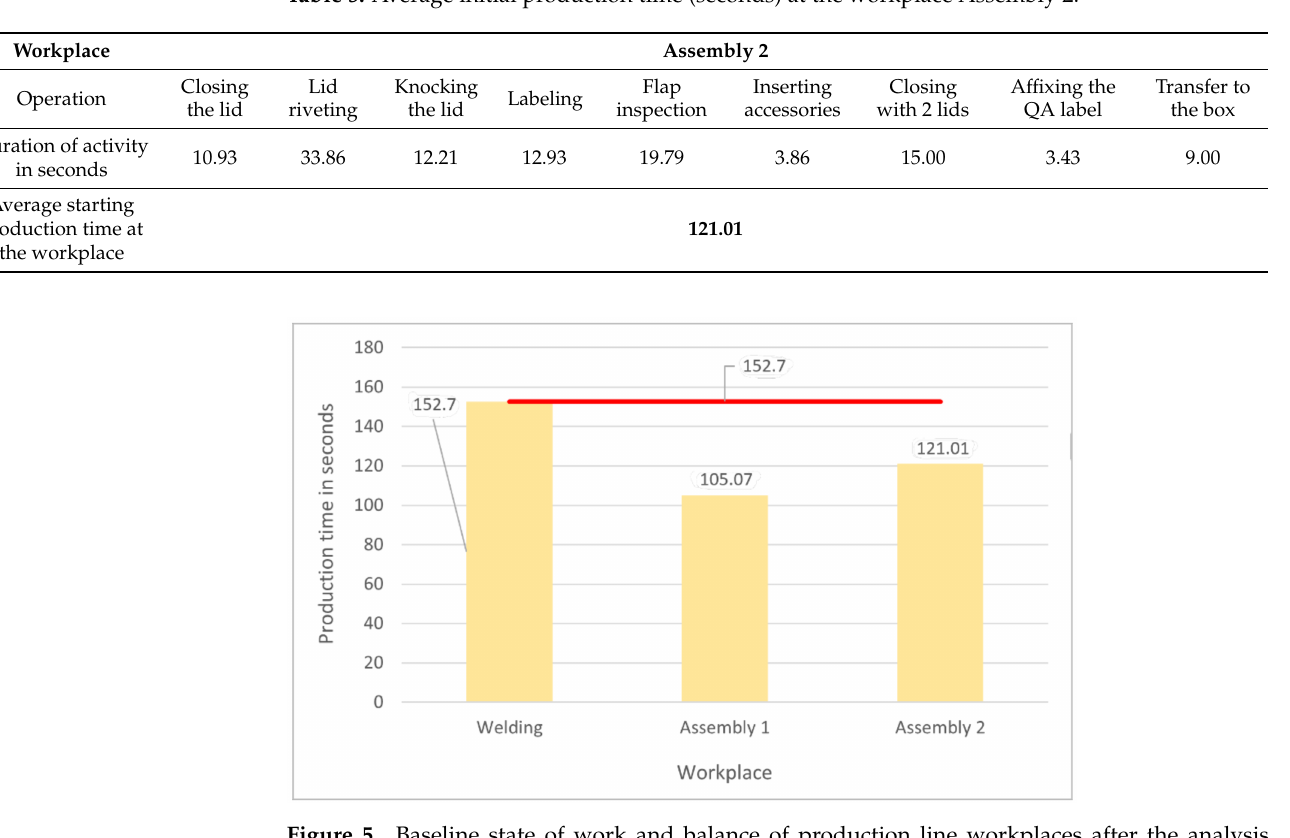
Table 5. Average initial production time (seconds) at the workplace Assembly 2.